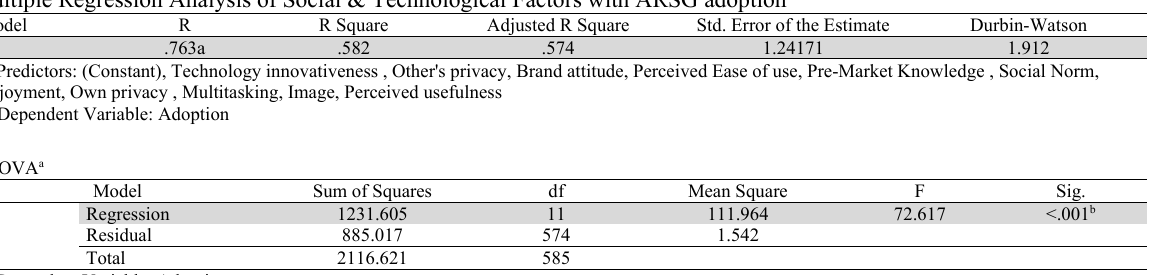
b. Predictors: (Constant), Technology innovativeness, Other's privacy, Brand attitude, Perceived Ease of use, Pre-Market Knowledge, Social Norm, En- joyment, Own privacy, Multitasking, Image, Perceived